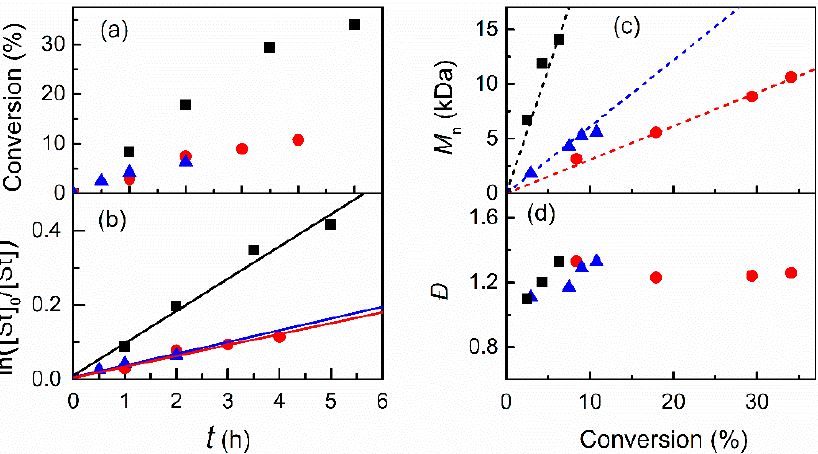
Figure 4. ( a ) Conversion, ( b ) kinetic plots and evolution of ( c ) M n and ( d ) Ð with conversion for potentiostatic e ATRP of 50% ( v / v ) styrene in DMF at E app = E 1/2 . For reaction conditions refer to Table 3, entry: 1 ( ■ ), 2 ( ● ) and 3 ( ▲ ) and. The dashed lines in (c) represent the theoretical molecular weight.